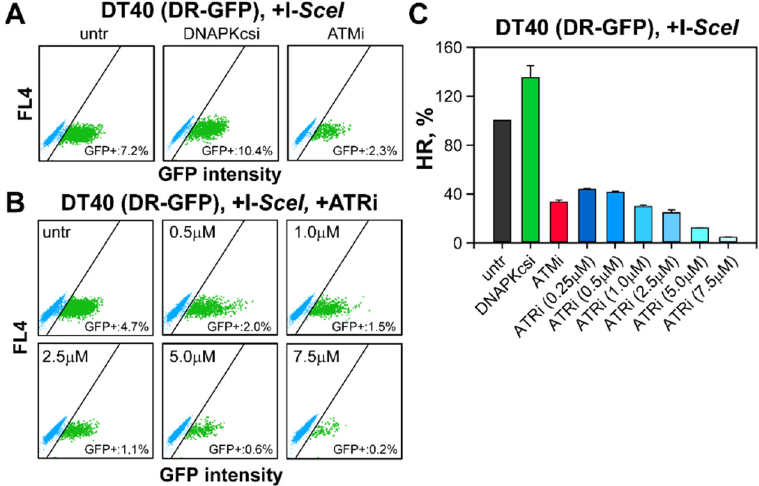
Figure 7. Repair of I- SceI induced DSBs in DT40 cells is comparable to DSB repair in U-2 OS, DR-GFP reporter cells: ( A ) Representative dot plots of GFP positive cells in DT40 (DR-GFP) cells. After transfection with I- SceI -expressing plasmids, cells were grown either in inhibitor-free media or in media containing DNA PKcs and ATM inhibitors. The GFP signal was analyzed 24 h after transfection; ( B ) Representative dot plots of GFP positive cells in DT40 (DR-GFP) clone, after treatment with increasing concentrations of ATRi; ( C ) Quantitative analysis of GFP positive cells in the experiments shown in Figure 7A,B. The percentage of GFP positive cells reflects DSB repair by HR (HR, %). HR efficiency in cells treated with PIKK inhibitors is calculated by normalizing to the levels of untreated cells. Data represents the mean and standard deviation from two experiments.